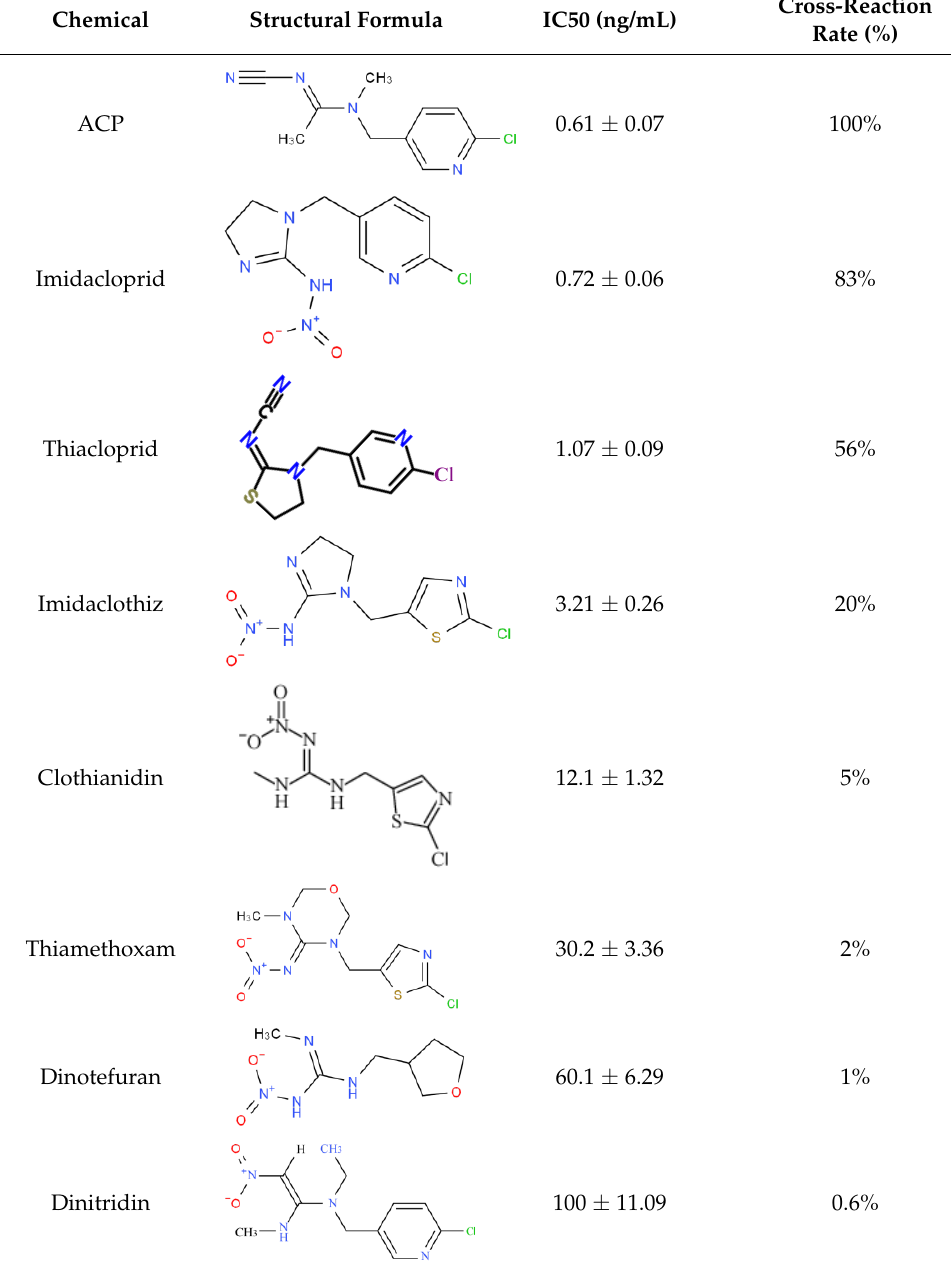
Table 1. Specificity of clone 1G2 anti-ACP mAb.